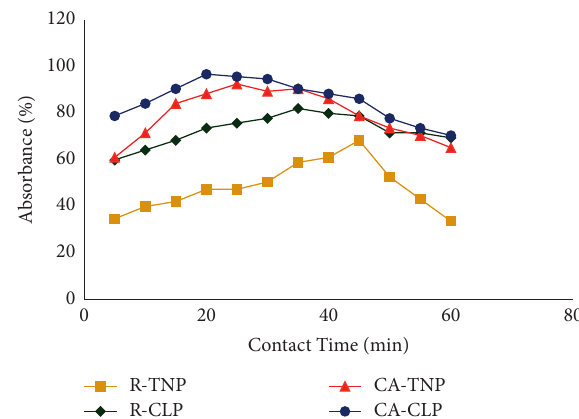
Figure 8: Effect of contact time on adsorption. Experimental conditions: contact time 5 to 60min, conc. � 25ppm, volume � 25 mL, temperature � 30 ° C, initial pH � 5, final pH: R-TNP � 5, R-CLP � 4.5, CA-TNP � 4.0, and CA-CLP � 4.0, adsorbent dose � 0.6 g, and ag- itation speed � 100rpm.